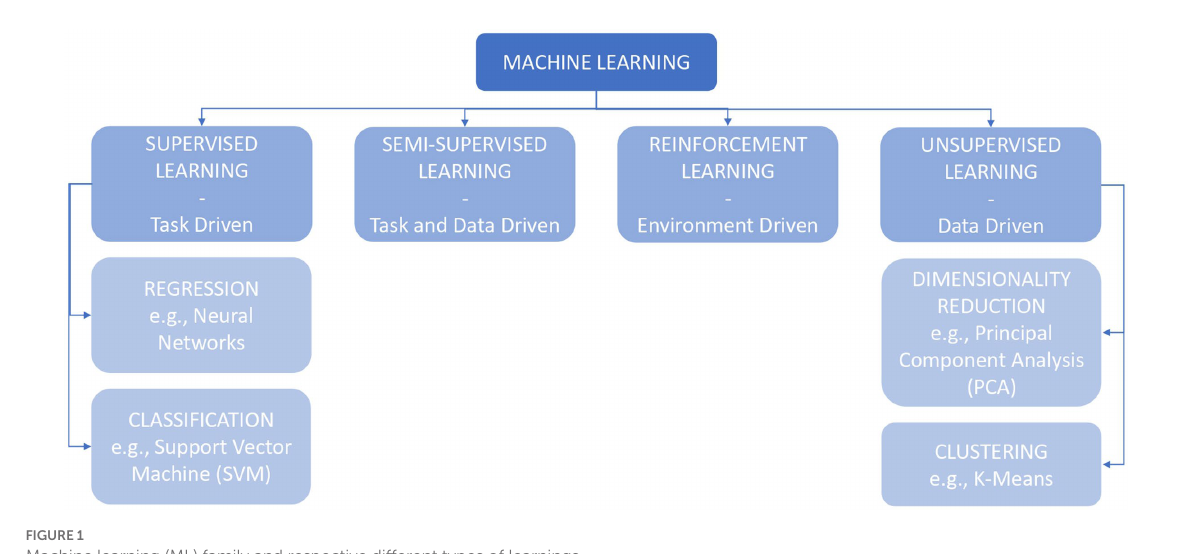
FIGURE 1 Machine learning (ML) family and respective different types of